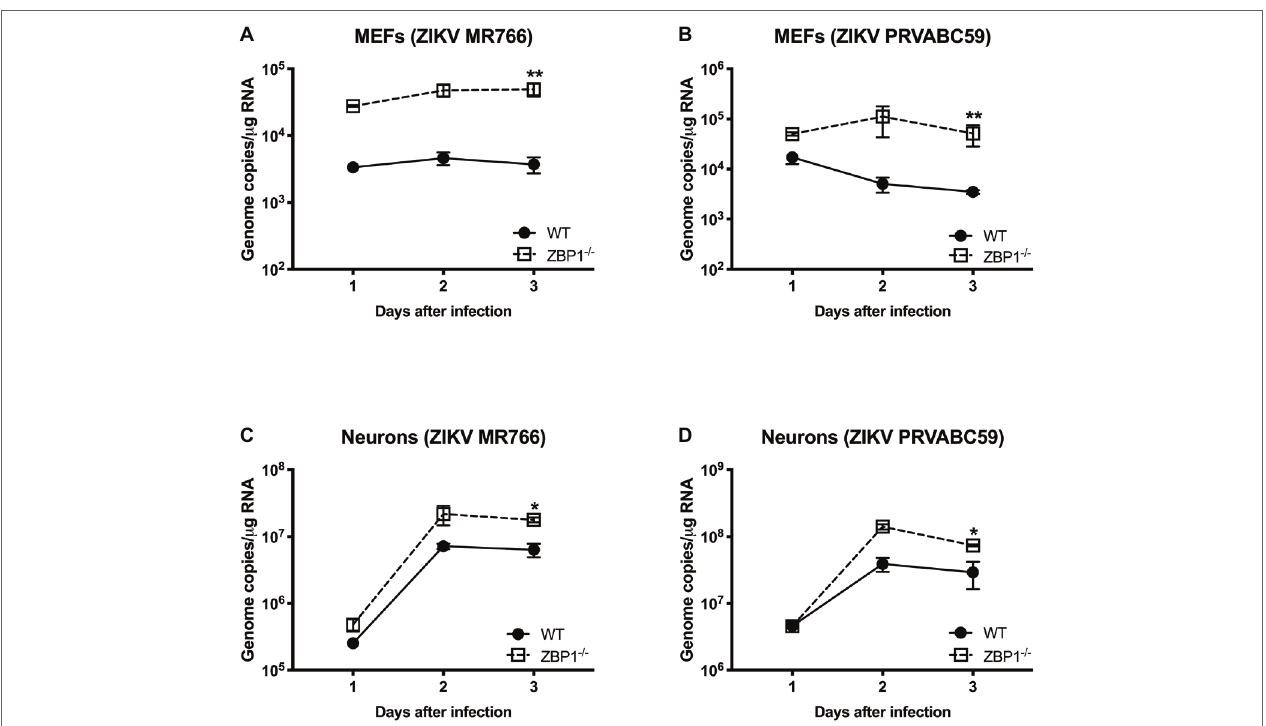
FIGURE 8 | ZIKV RNA levels in the MEFs and neurons isolated from WT and ZBP1 −/− mice. (A–D) Cells were infected with ZIKV MR766 or ZIKV PRVABC59 at a MOI of 1. Total RNA was extracted from cell lysates and ZIKV RNA was measured by qRT-PCR (expressed as genome copies/μg of RNA). Error bars represent SEM (three independent experiments conducted in duplicate), * p < 0.05, ** p < 0.001.